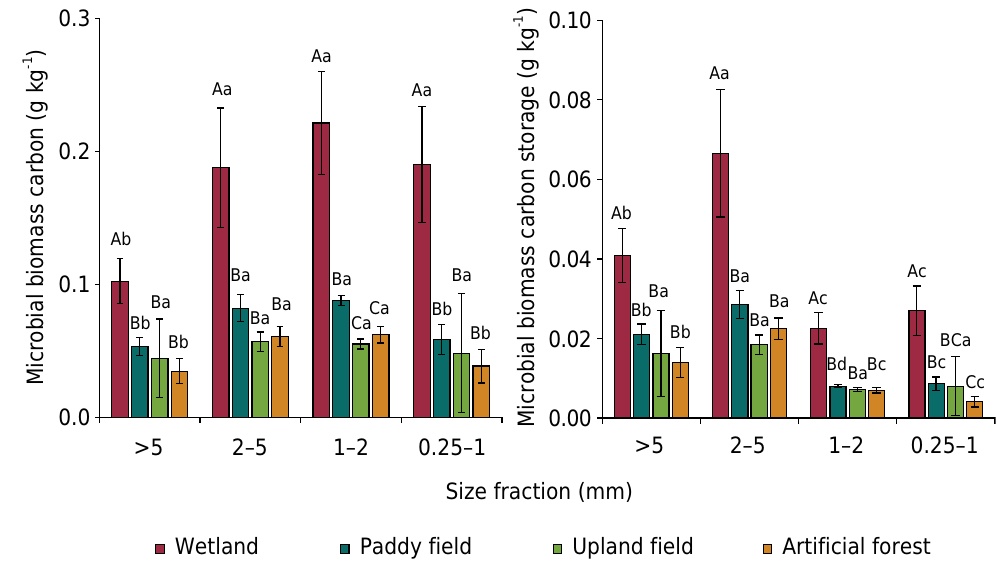
Figure 5. Content and storage of microbial biomass carbon in soil aggregates from different land-uses in the Sanjiang Plain wetlands. Capital letters represent the differences between different land-uses types at the same soil aggregates. Lowercase letters represent the differences of the same land-use type in different soil